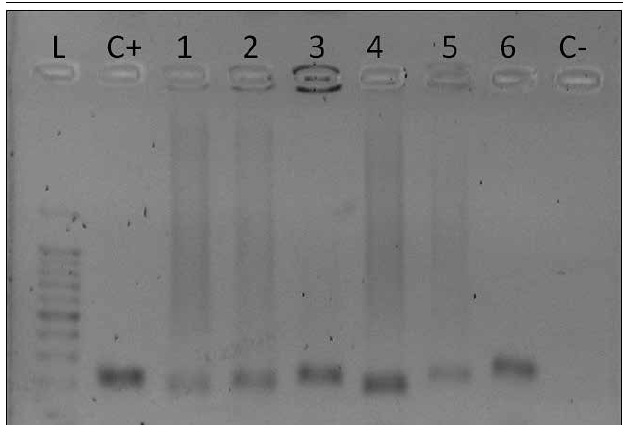
figurE 2 – Agarose gel (1,5%) stained with blue green loading dye showing PCR electrophoretic profile using PCO3/PCO4 oligonucleotide primers for human ß-globin gene detection corresponding to ~110 pb